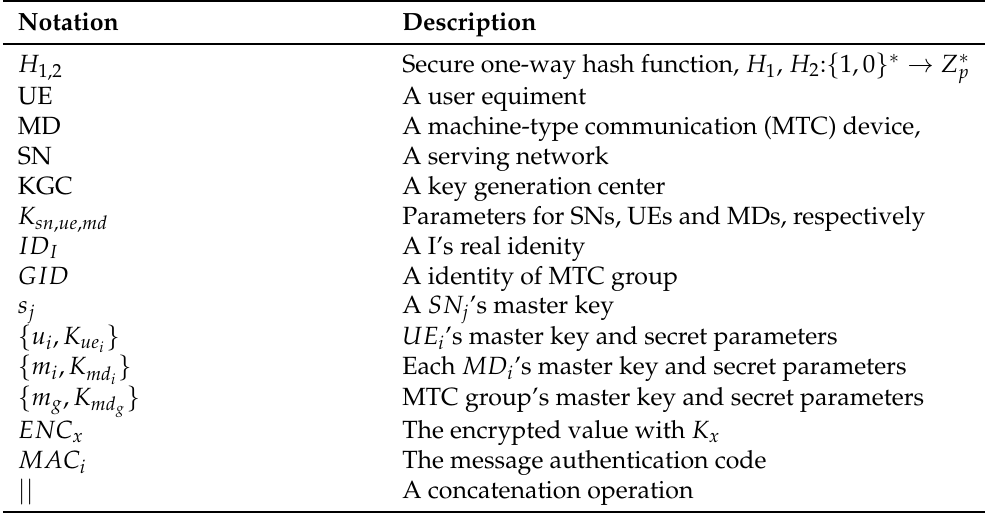
Table 1. Notation used in this